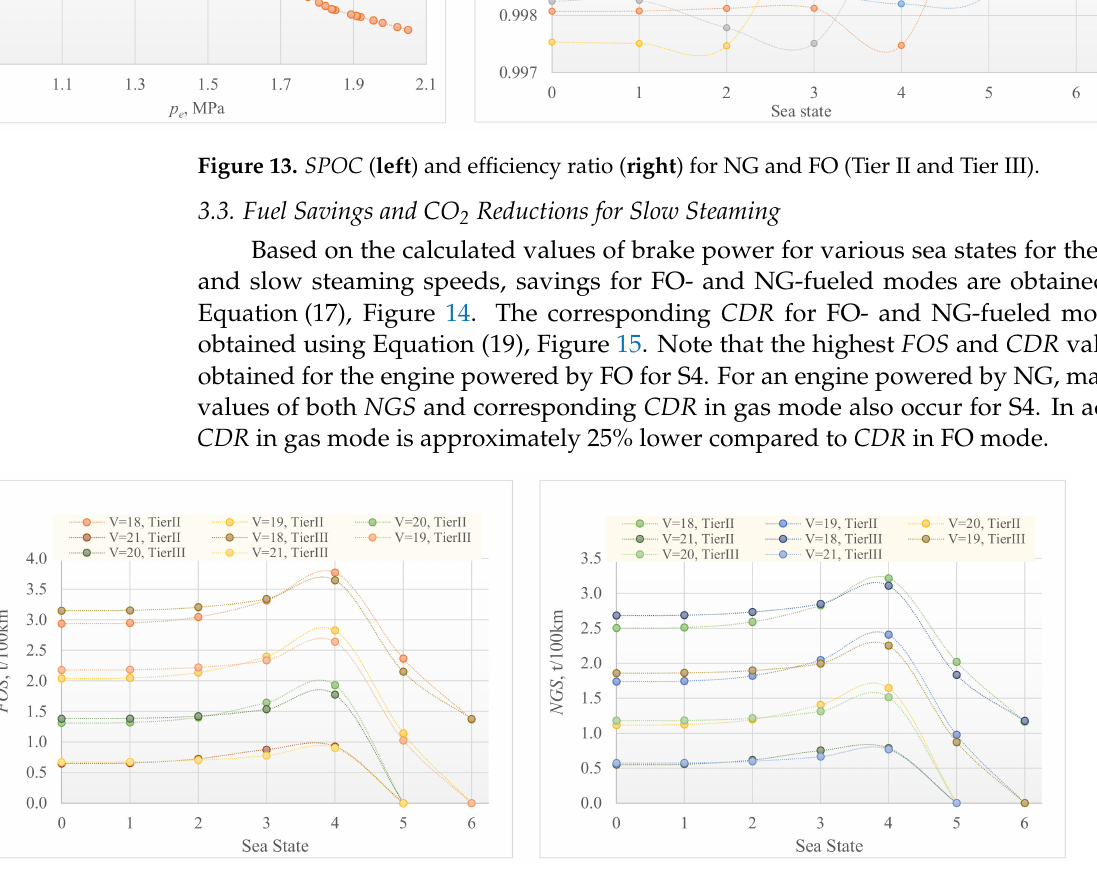
Figure 14. FOS ( left ) and NGS ( right ) per 100 km of the sailing route in Tier II and Tier III mode for slow steaming